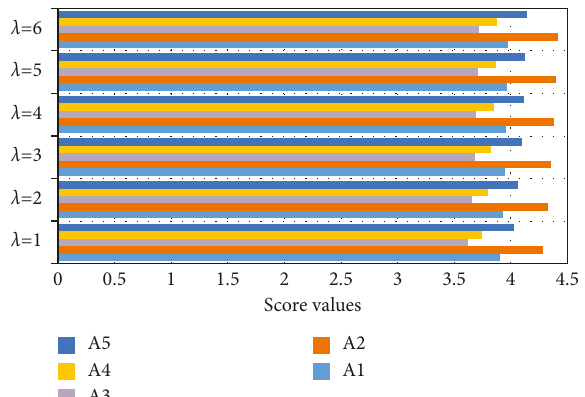
Figure 5: Score values for thermal power stations A